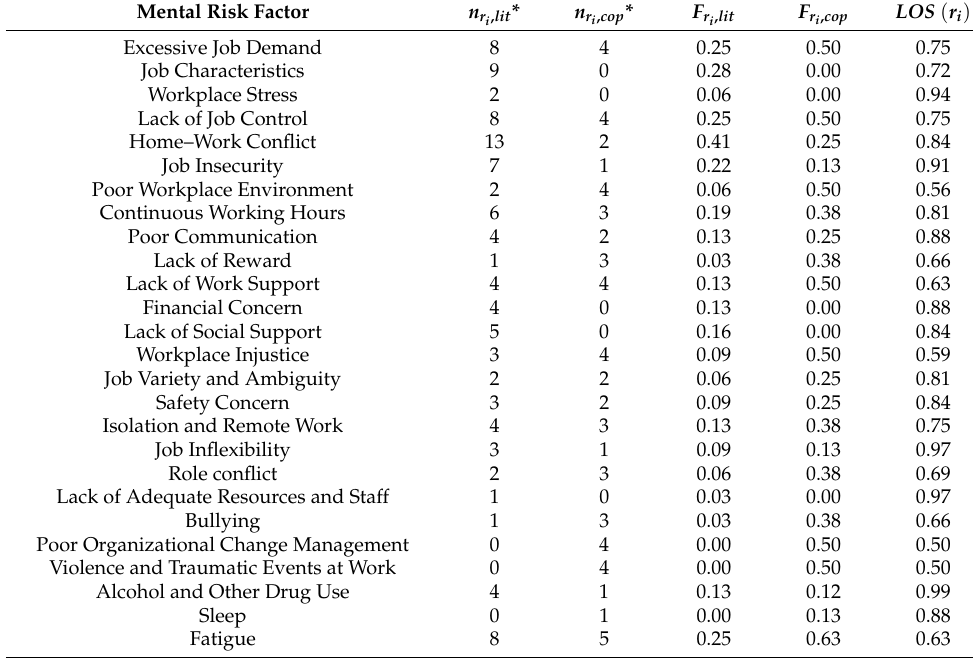
Table 6. Quantitative comparison of the selected standards and literature regarding the identified mental risk factors.